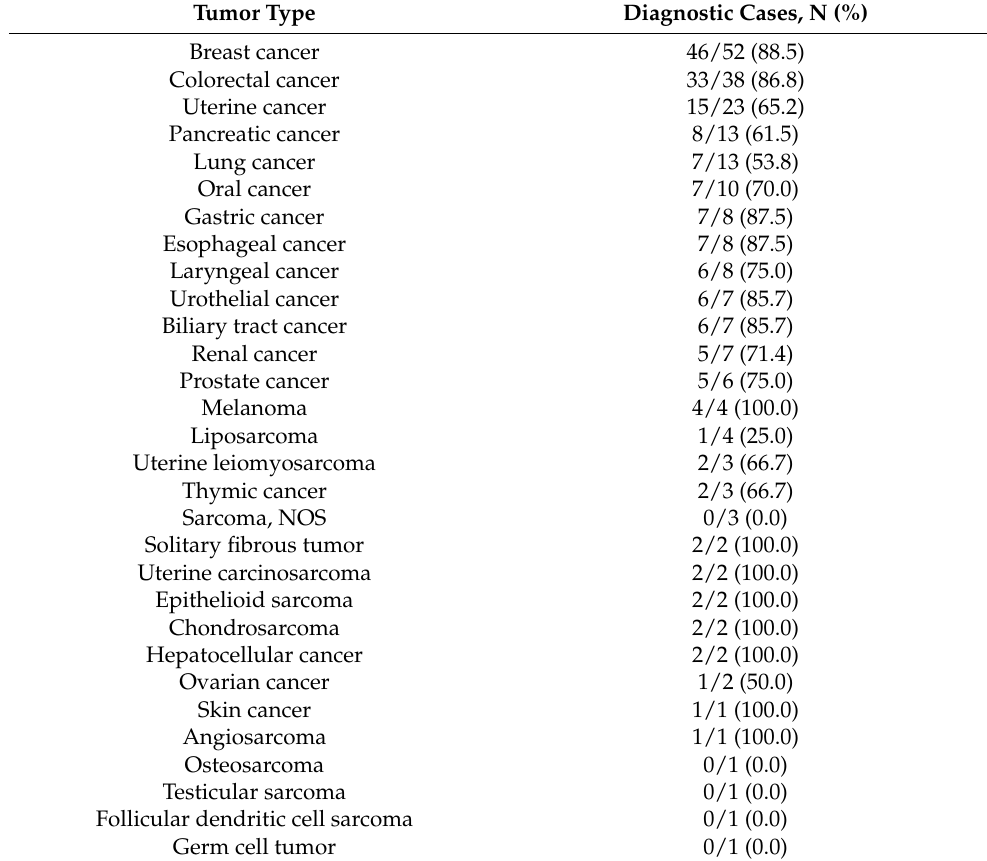
Table 3. Tumor types and associated diagnostic yield.